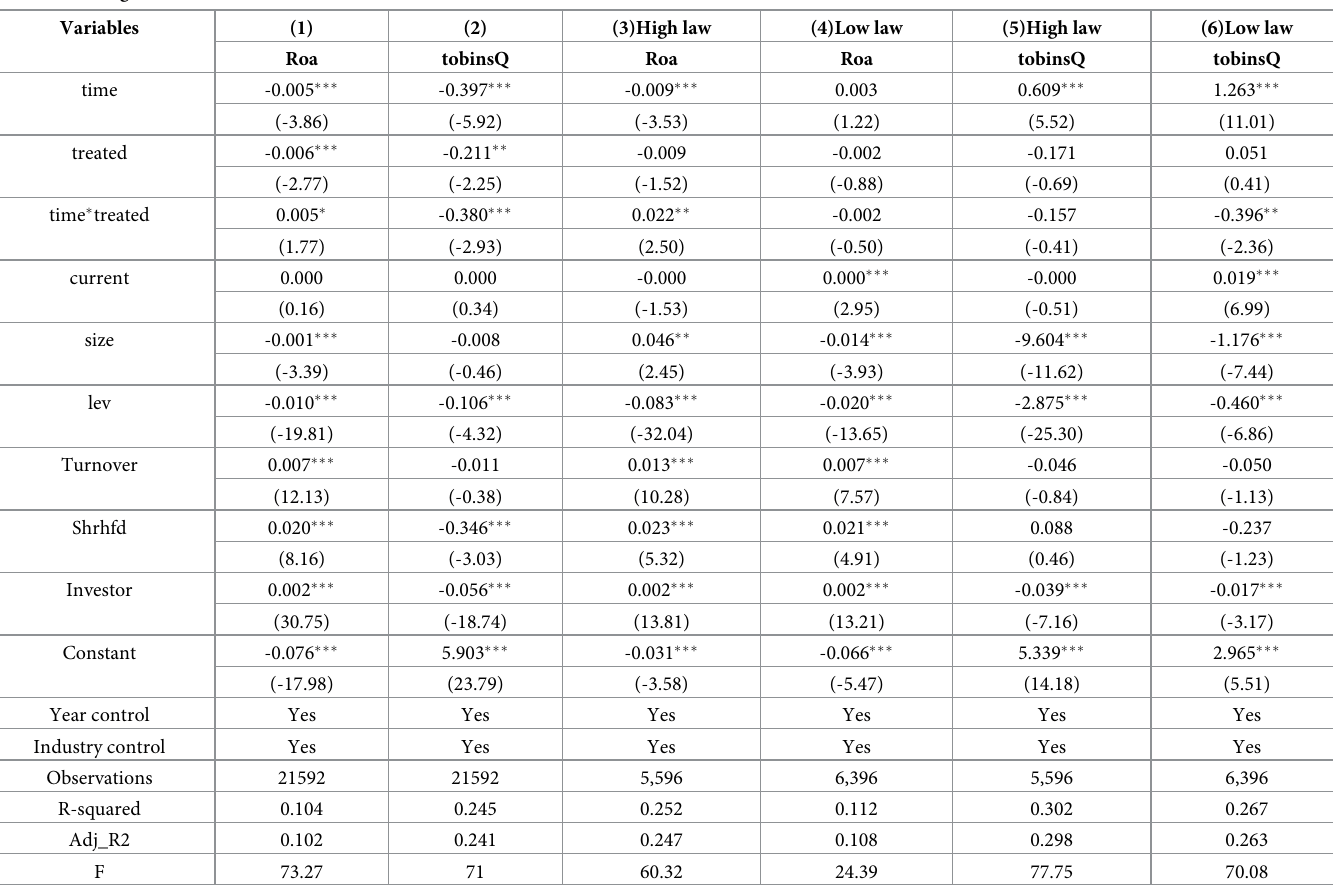
Table 3. The regression